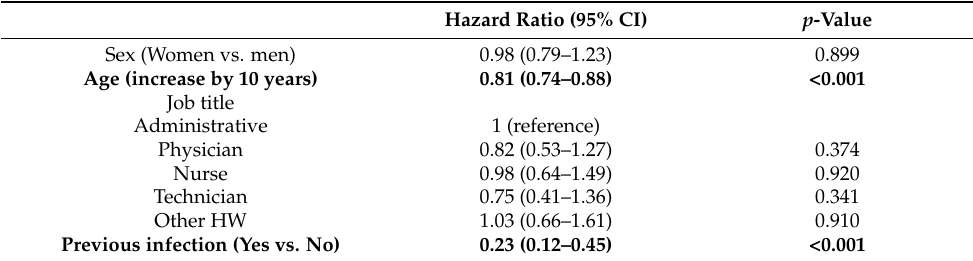
Table 2. Main risk factors of breakthrough infection in the eight centers (31,837 HWs). Hazard ratios and p -values were obtained by a Cox regression model, including sex, age, job title, and pre-vaccine SARS-CoV-2 infection, stratifying by center.